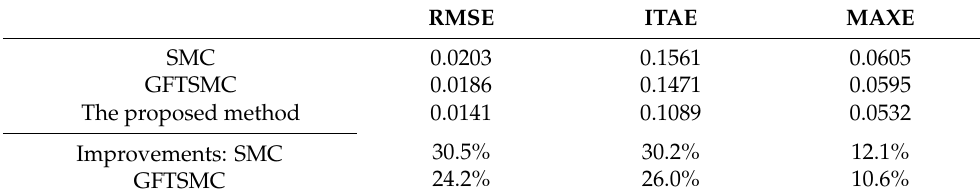
2 x  . Table 2. Comparisons of SMC, GFTSMC and the proposed method.